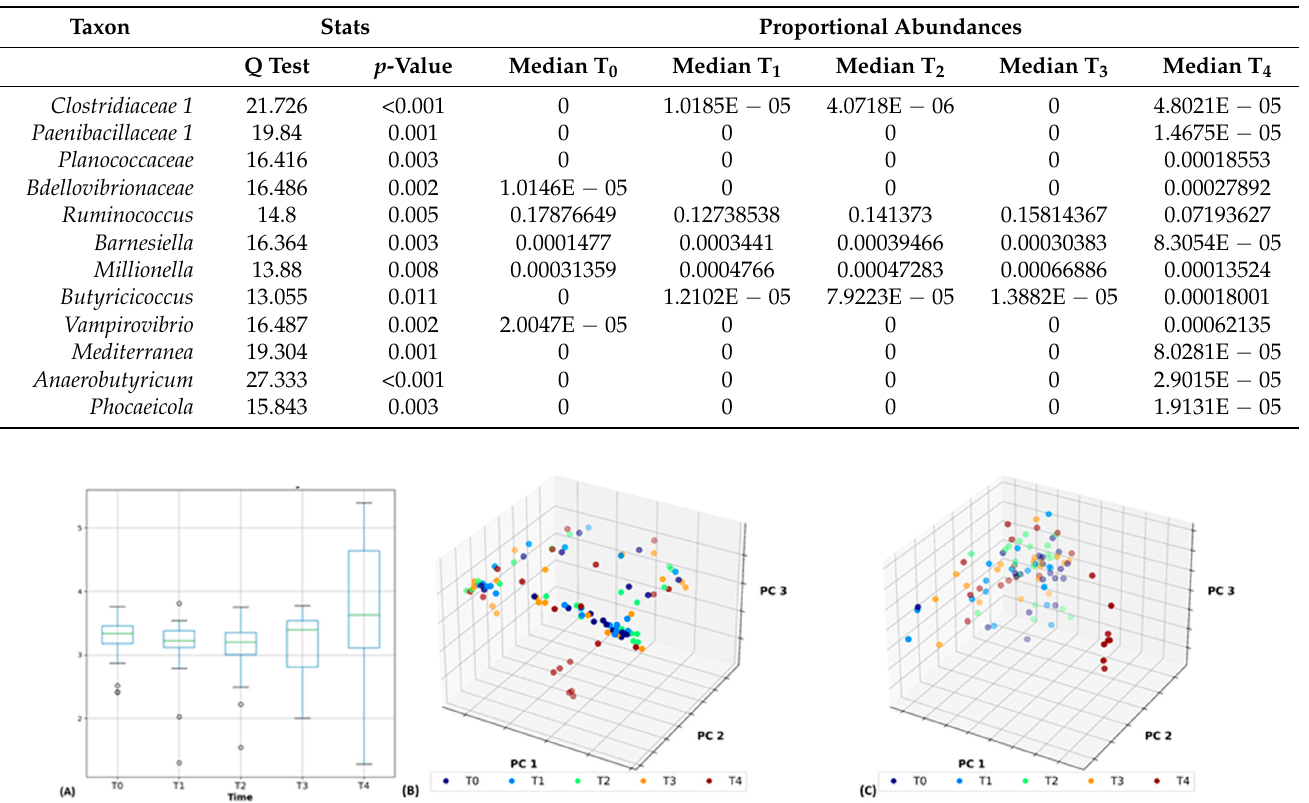
Table 1. Taxa with significant differences between time points.